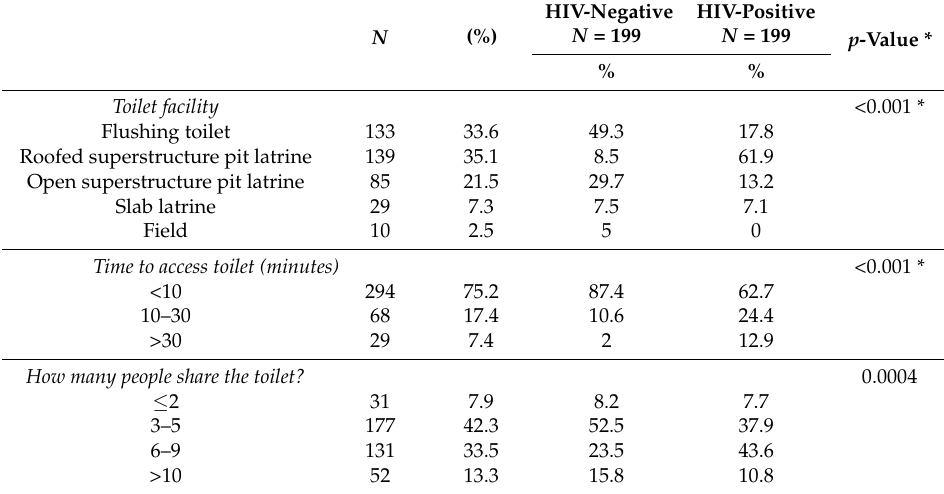
Table 5. A comparison of sanitation indicators among the HIV-negative and HIV-positive groups in Wukro ( N =